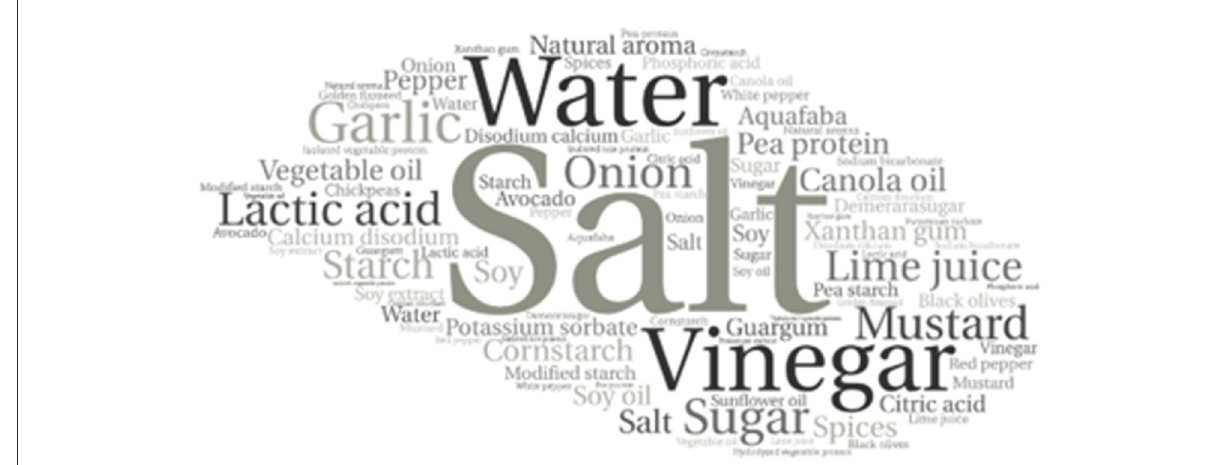
FIGURE4 Word cloud generated from the frequencies of used ingredients in mayonnaise and eggs.